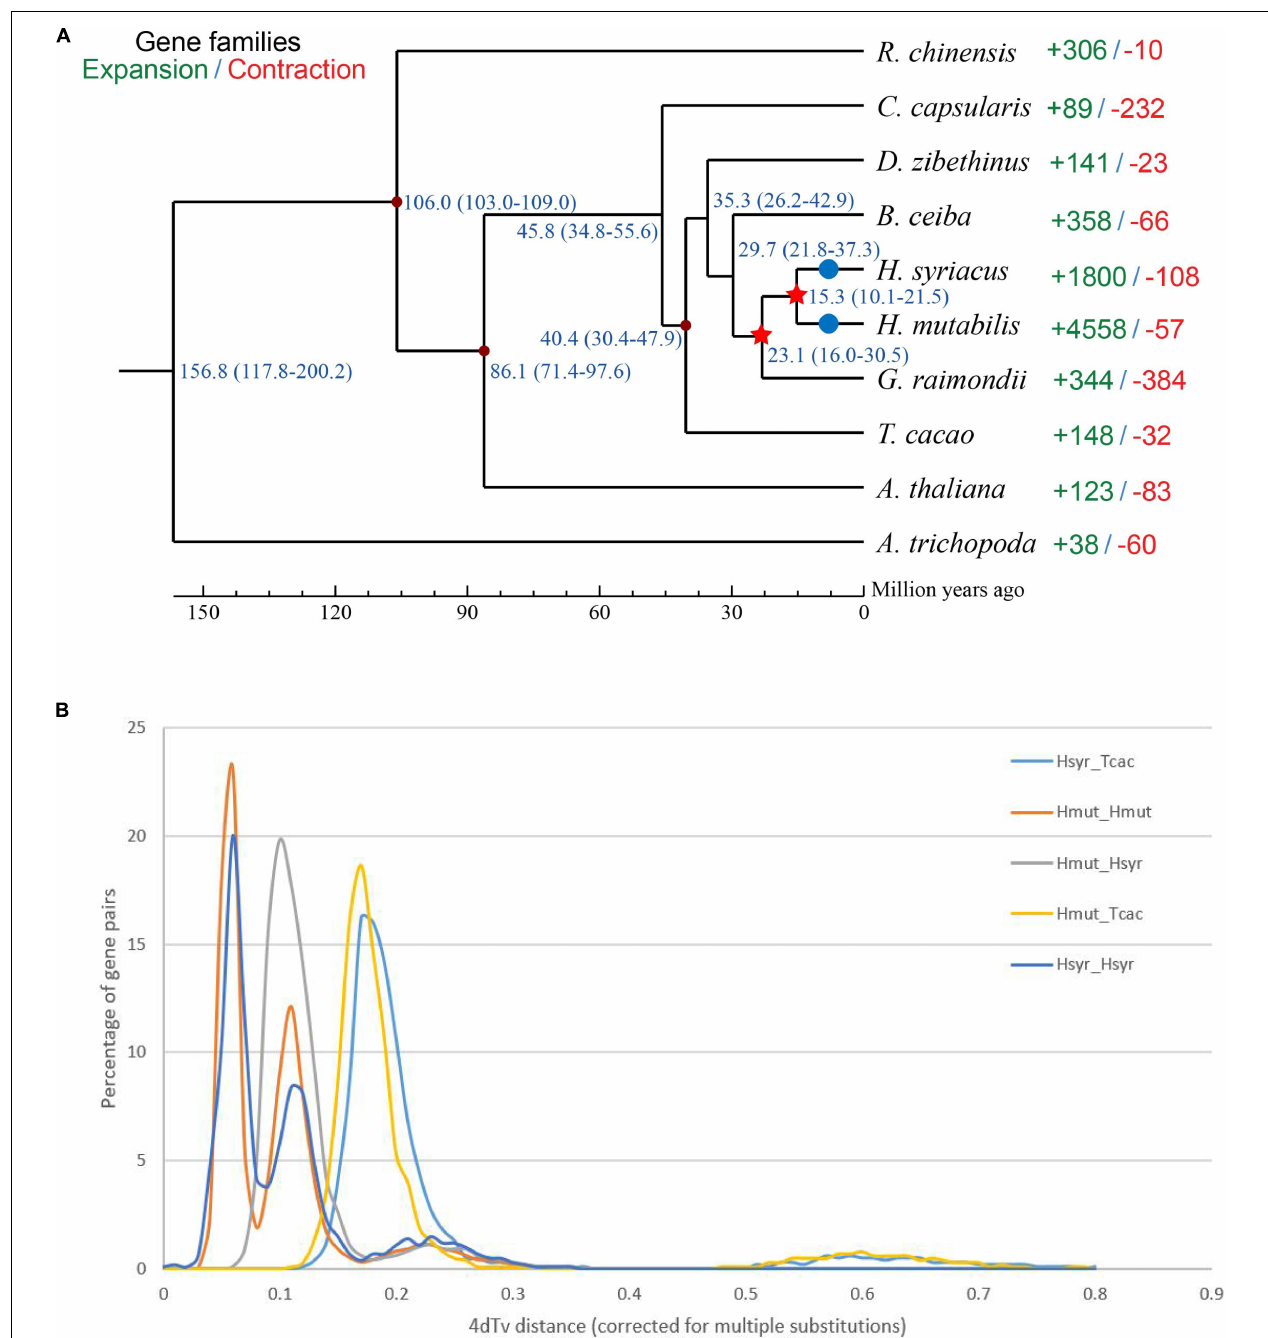
FIGURE 5 | (A) Phylogenetic tree showing the close relationship between H. mutabilis and H. syriacus . Numbers outside the parentheses represent the divergence times of species (Mya), and numbers inside the parentheses indicate the confidence intervals. The red points indicated calibration points, and the red stars indicate WGD events and blue circles indicate diploidization events. (B) Distribution of 4Dtv distances.